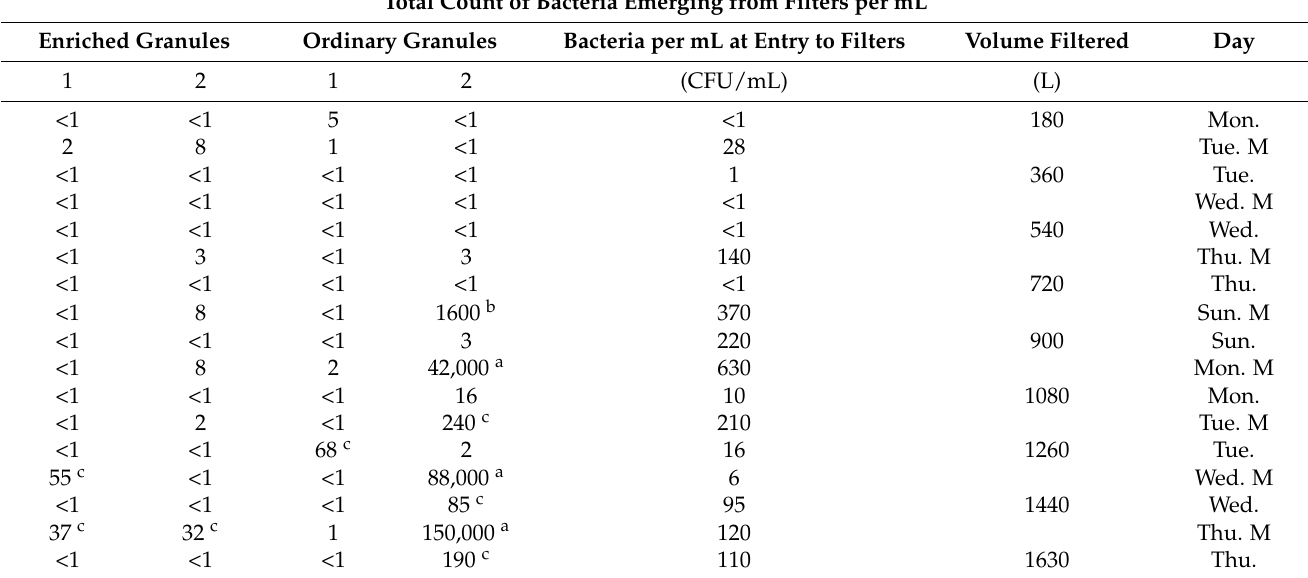
Table 1. Removal of bacteria from drinking water by filters containing an ordinary or enriched granular complex (10% increased amount of cation during preparation of complex).